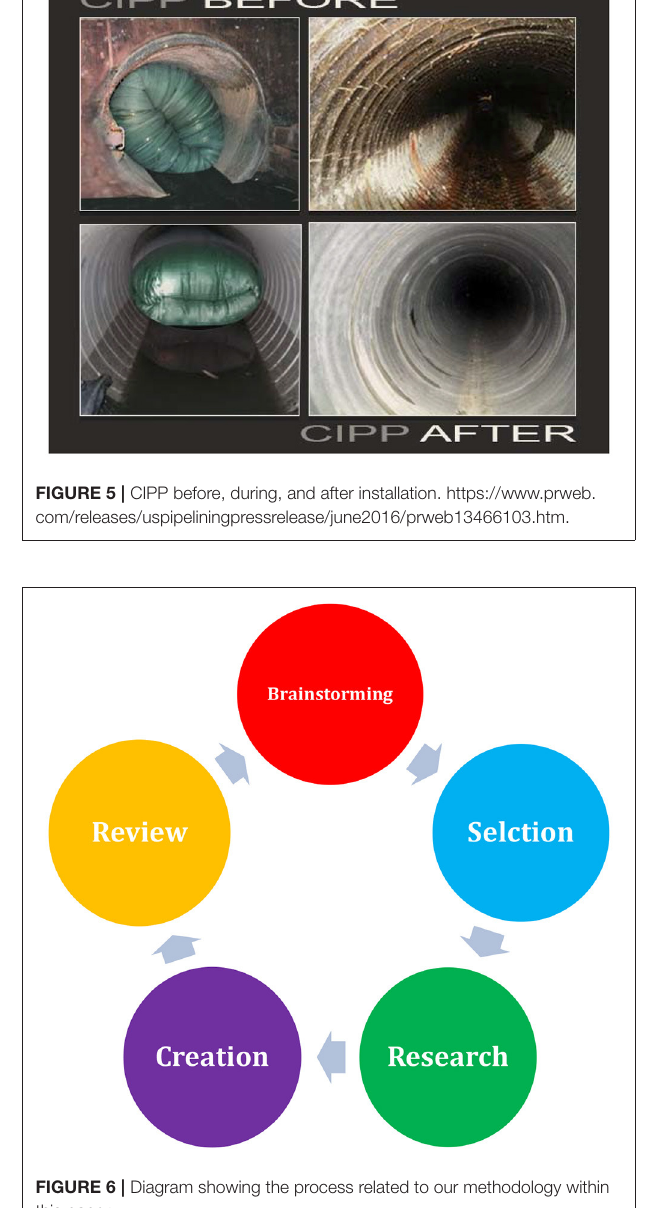
FIGURE 6 | Diagram showing the process related to our methodology within this